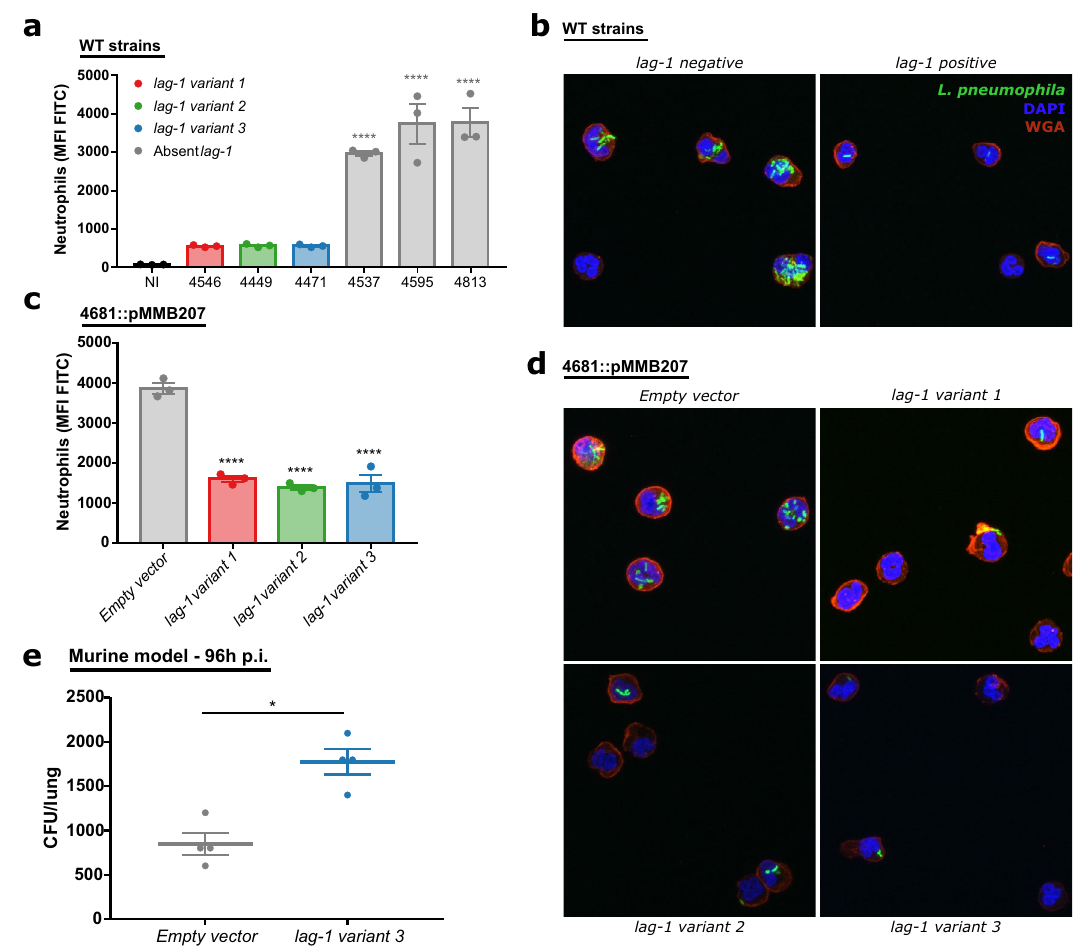
Fig. 7 lag-1 confers resistance to human neutrophil phagocytosis and enhances surival in a murine model of pneumonia. a to d lag-1 confers resistance to human neutrophil phagocytosis. WT lag-1 -positive and -negative strains expressing DsRed fl uorescent protein, as well as isogenic mutants of L. pneumophila isolates expressing the lag-1 variant 1, 2 or 3, were stained with FITC and pre-incubated with 10% human serum 15 min prior incubation with human neutrophils for 30 min. a and b Phagocytosis was evaluated by measuring neutrophils FITC fl uorescence by fl ow cytometry. Each point represents a technical replicate for a single donor. Data are representative of three independent experiments. L. pneumophila strains expressing lag-1 variant 1, 2, or 3 are represented in red, green, or blue, respectively. Strains that do not express a functional lag-1 gene are represented in grey. Non-infected (NI) neutrophils are represented in black. Bars represent mean + / − SEM. One-way ANOVA, Dunnett ’ s multiple comparisons test to non-infected control or to Empty vector , ** p < 0.01, **** p < 0.0001. Source data and exact p -values are provided in the Source Data fi le. c and d Representative images of L. pneumophila- infected human neutrophils obtained by confocal microscopy and maximum intensity algorithm. Bacteria are represented in green, cytoplasmic membrane in red and nucleus in blue. e lag-1 expression increases L. pneumophila lung survival. C57BL/6J mice were intranasally infected with 1 × 10 6 L. pneumophila cells in 40 μ L of PBS and bacterial numbers in the lungs evaluated 96 h post infection. Each point represents an individual animal ( n = 4 in each group). Data are presented as mean + / − SEM. Two-tailed Mann – Whitney t- test * p < 0.0286. Source data are provided as a Source Data fi